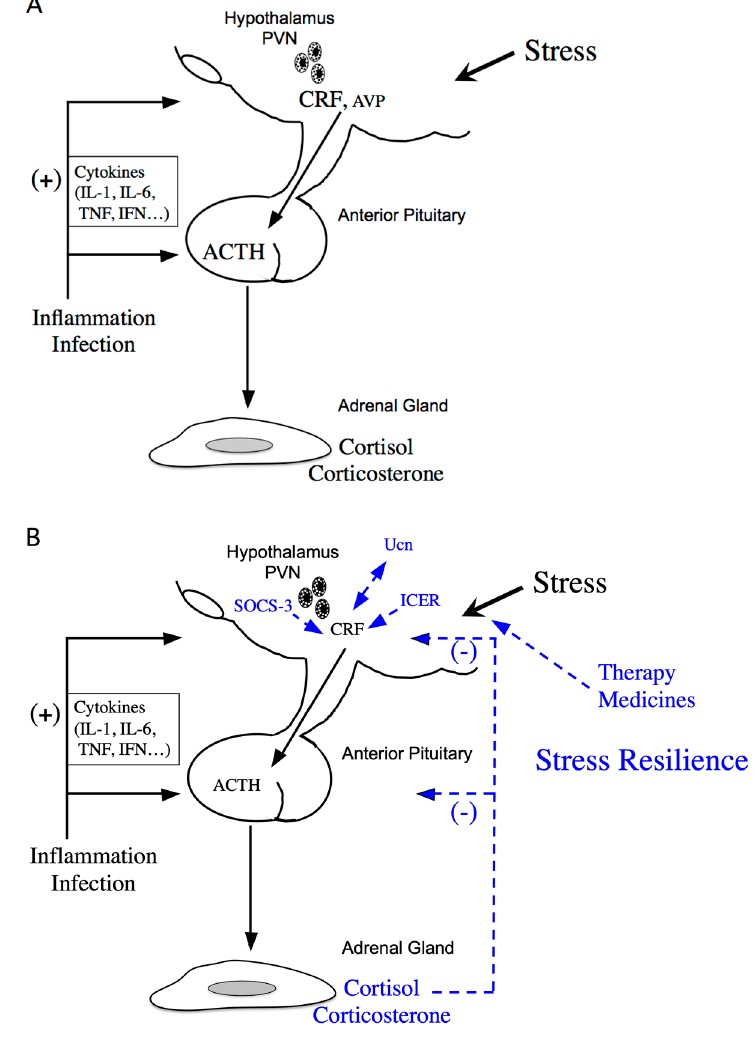
Figure 1. Schematic model of hypothalamic-pituitary-adrenal (HPA) axis regulation. ( A ) Activation of the HPA axis under stress. Corticotropin-releasing factor (CRF) plays a central role in controlling stress responses. Cytokines also stimulate CRF production under inflammation or infection. CRF, produced in the hypothalamic paraventricular nucleus (PVN), stimulates adrenocorticotropic hormone (ACTH) production from the corticotrophs of the anterior pituitary (AP). ACTH then stimulates corticosterone and cortisol release, the principal glucocorticoids in rodents and human, respectively, from the adrenal glands. ( B ) Regulation of the HPA axis under stress resilience. Glucocorticoids are produced by ACTH in the adrenal glands. Circulating glucocorticoids are critical for recovery from stress conditions. Both inducible cAMP-early repressor (ICER) and suppressor of cytokine signaling (SOCS-3) contribute to the negative regulation of CRF synthesis in the hypothalamus. The urocortin (Ucn)-CRF receptor type 2 mediates “stress coping” responses. Therapy or medicines also target this to alleviate stressed states.